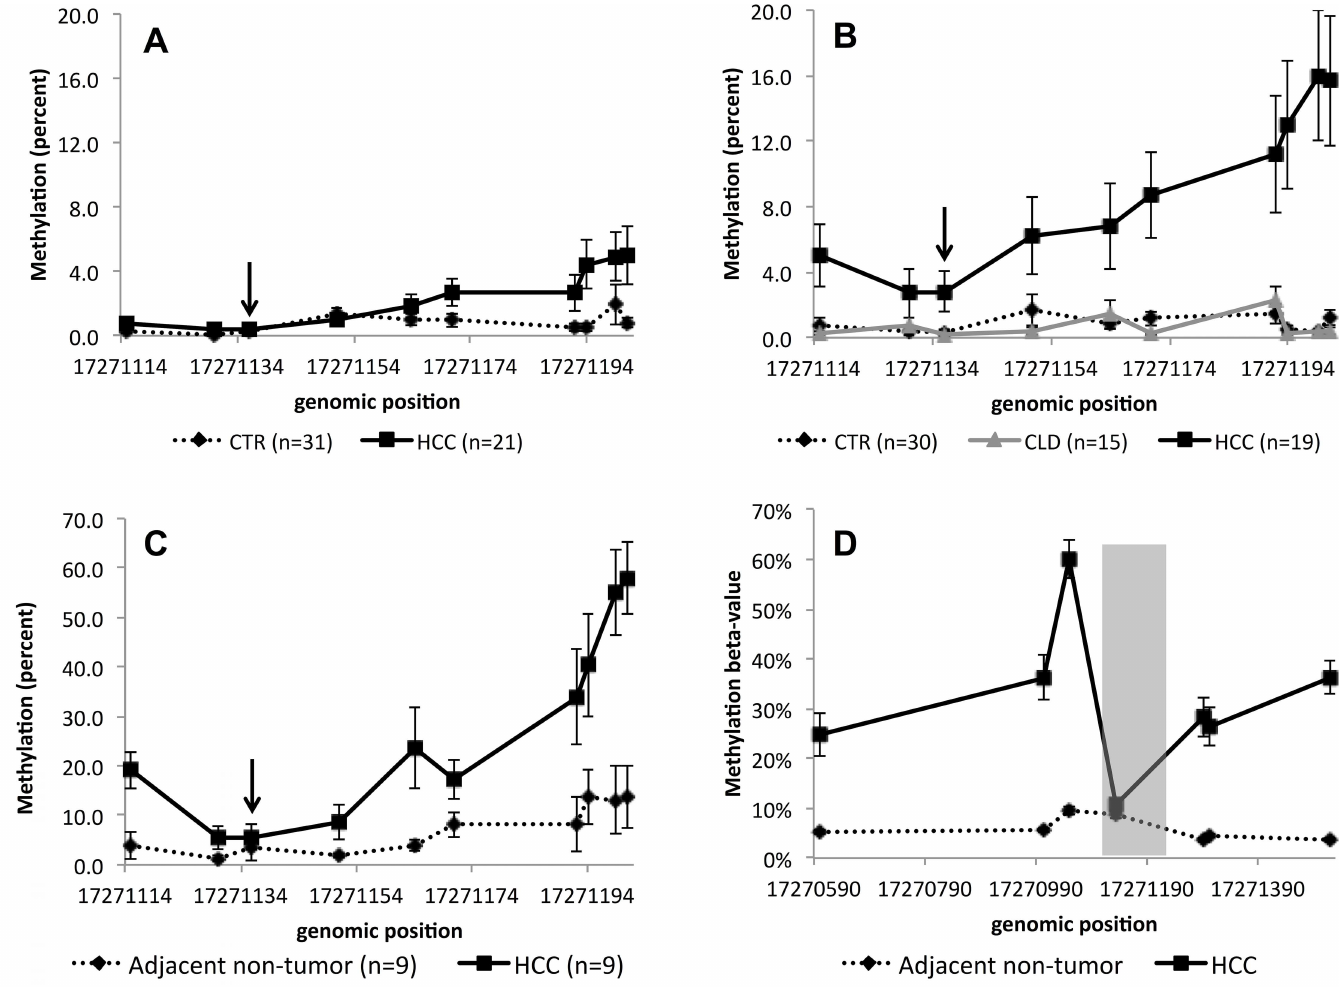
Fig 2. VIM methylation in cfDNA. Cases from France (A) and Thailand(B), in tissue (C) (the arrows show the CpG-site analysedin TCGA data) and in TCGA data (D) (the grey area represents the area analyzedby massivelyparallelsequencing in this study). CTR: controls, HCC: hepatocellular carcinoma patients and CLD: chronic liver diseases. The error bars represent standarderror of